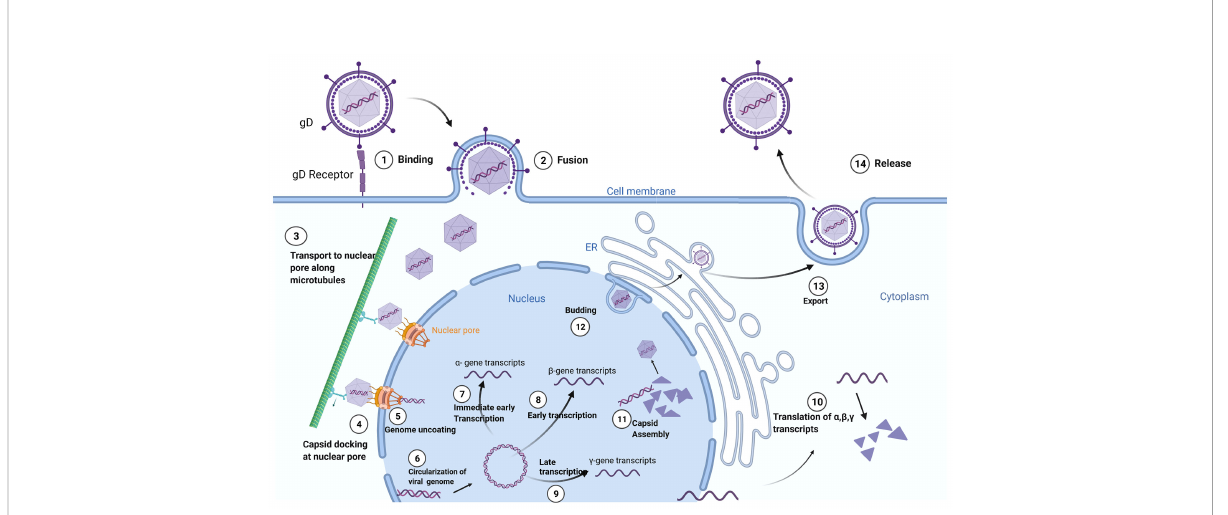
FIGURE 1 Herpes Simplex Virus-1 (HSV-1) Life Cycle: Adsorption and fusion of HSV-1 to its target cell is initiated by viral glycoprotein D (gD) to cell speci fi c gD receptors (1). Fusion of the viral envelope with cell membrane allows for capsid entry into the cytoplasm and release of tegument proteins (2). The naked viral capsid is transported (3) to nuclear pore complexes in the nuclear envelope (4), through which the viral genome is extruded into the nucleus (5). The linear viral genome is circularized (6). Herpes viruses have three rounds of transcription: immediate early ( a - genes) (7), early ( b -genes) (8), and late ( g -genes) (9). Translation of the structural proteins from g - transcripts occurs only after the initiation of viral genome replication, which is dependent on b -proteins. Viral transcripts leave the nucleus to be translated (10) in either the cytoplasm or in the context of the endoplasmic reticulum (ER). Capsids are assembled in the nucleus, encasing the viral genome in an icosahedral protein coat (11). The newly generated viral capsid acquires an envelope by budding into the inner nuclear membrane (12). The completed virus translocates through the ER and matures in the Golgi apparatus prior to exiting the cell by exocytosis (13). Created with